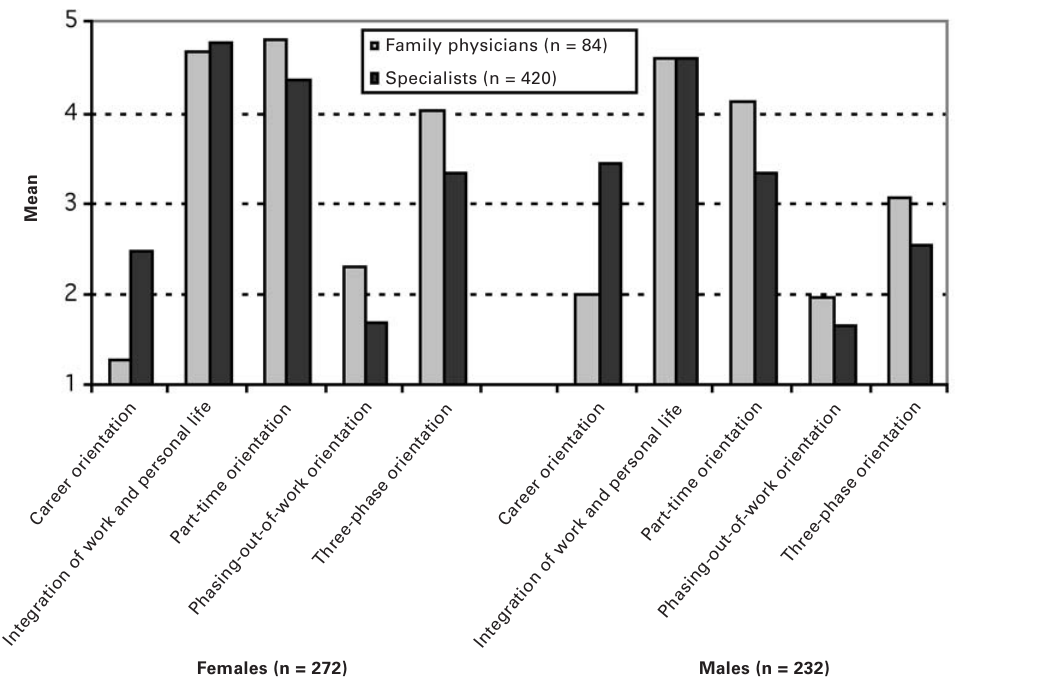
model 2. Half of the specialists favour model 1.